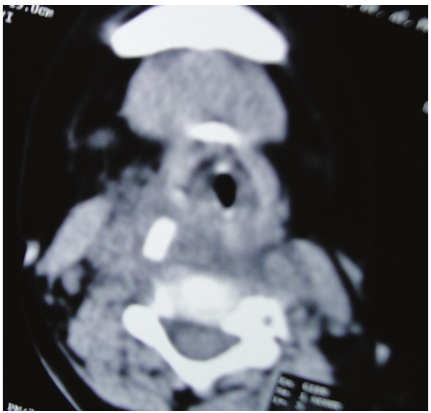
Figure 3: CT scan showing the lowermost part of the toothbrush in the retropharyngeal space of the hypopharynx.